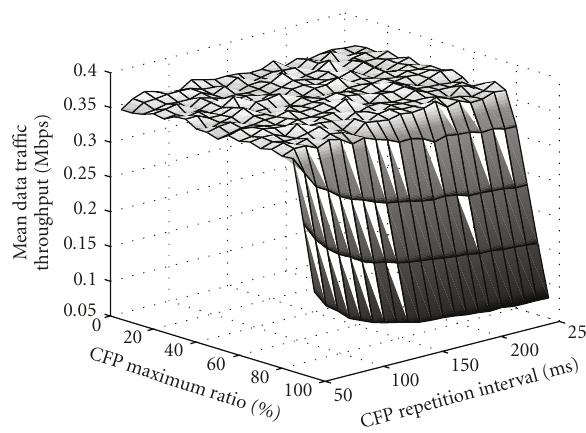
Figure 8: Mean data throughputs for various CFP MAX .